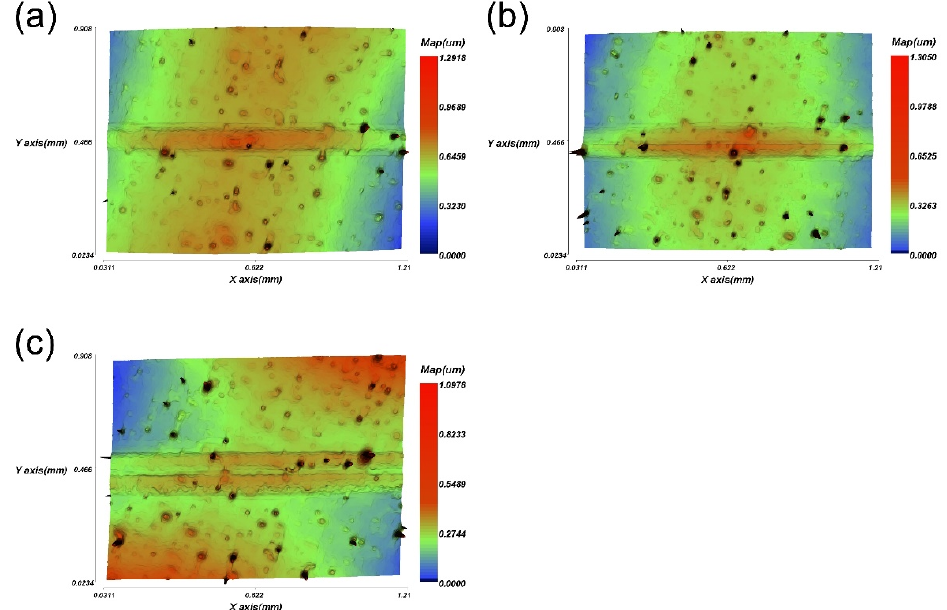
Figure 6. Interferometer images of printed strain gauges according to the pattern width: ( a ) two droplets, ( b ) four droplets and ( c ) seven droplets.